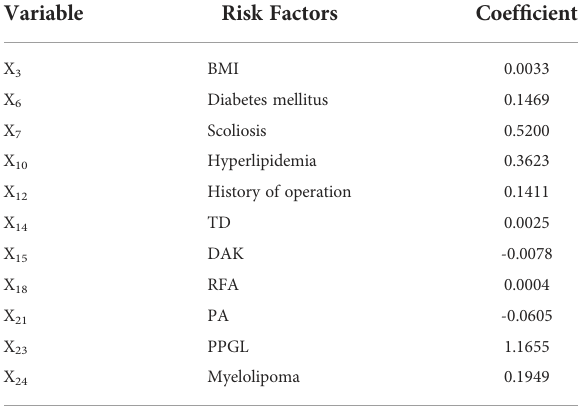
TABLE 4 Risk factors selected by LASSO-logistic regression model.